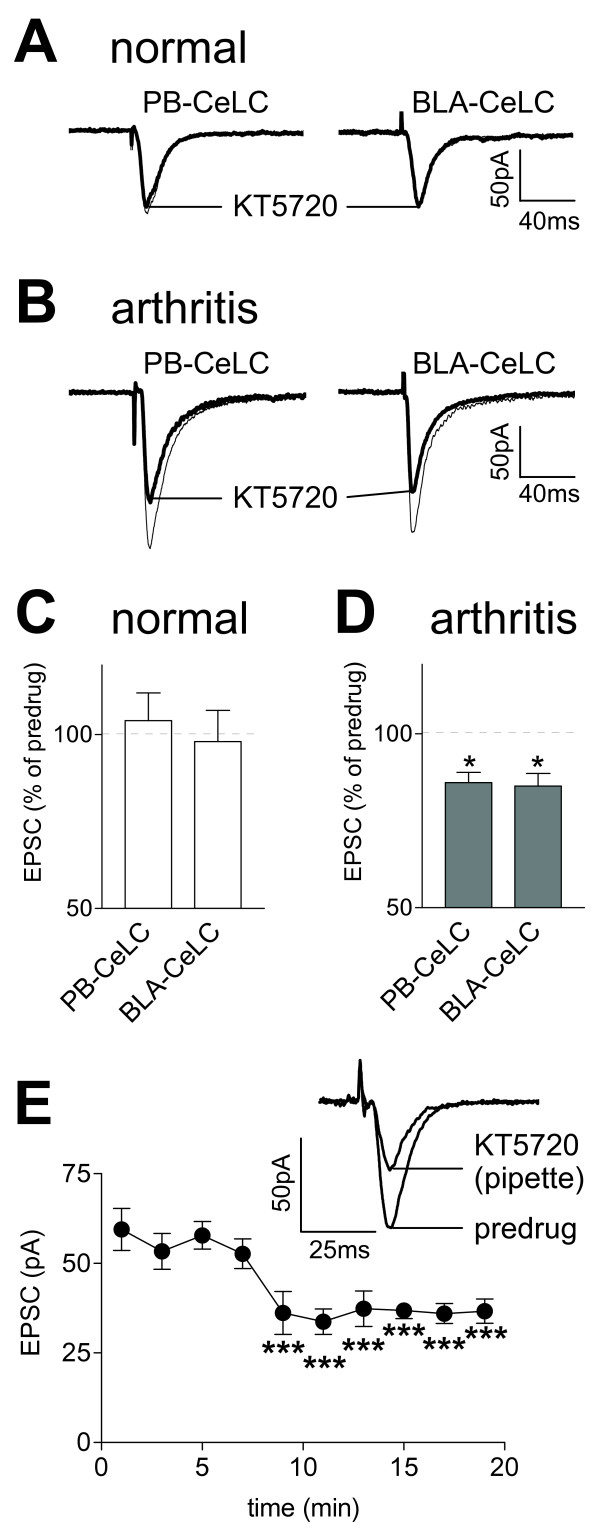
A PKA inhibitor (KT5720) inhibits synaptic plasticity but not normal synaptic transmission. Monosynaptic EPSCs were evoked at the PB-CeLC and BLA-CeLC synapses in slices from normal (A, C) and arthritic (6 h postinduction; B, D, E) rats. KT5720 (1 μM, 15 min) inhibited synaptic transmission in neurons from arthritic rats 6 h postinduction (D, n = 7; P < 0.05, paired t-test) but not in control neurons from normal rats (C, n = 7). (A, B) Original recordings of EPSCs (average of 8–10 EPSCs) evoked at the two synapses. (C, D) Averaged EPSC amplitudes (mean ± SE) in the presence of KT5720 normalized to predrug (ACSF) control values (set to 100%). (E) Time course of the inhibitory effect of direct intracellular application of KT5720 (1 μM) through the patch pipette. Each symbol shows averaged EPSC amplitudes (mean ± SE; n = 4) at different times after whole-cell configuration was obtained (t = 0). The inhibitory effect was significant (P < 0.001, compared to the first EPSC after patch formation; Dunnett's Multiple Comparison Test). Insets show EPSCs (average of 8–10 trials) evoked at the PB-CeLC synapse at 1 min (predrug) and at 15 min (KT5720) after patch formation. Whole-cell voltage-clamp recordings were made at -60 mV. * P < 0.05, *** P < 0.001.